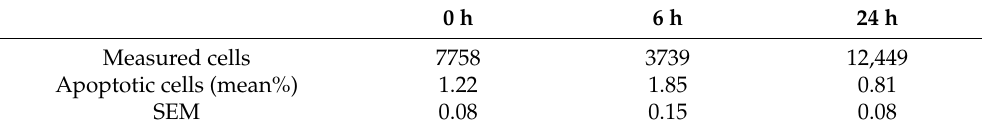
Figure 9. Live-dead assay on printed MDA-MB-468 cells. Representative images of printed cells at 0 h ( left ) and 24 h ( right ). All cells were counterstained with DAPI (blue), while dead cells were also positive for PI (red). The insets on top right are enlargements of the squares in the center of each image with shifted overlay of the red channel (~10 μ m) to the right to visualize the DAPI-stained nuclei underneath. Scale bars: 100 μ m. Table 3. The apoptotic fraction of LIFT-printed MDA-MB-468 at 532 nm at the indicated timepoints.